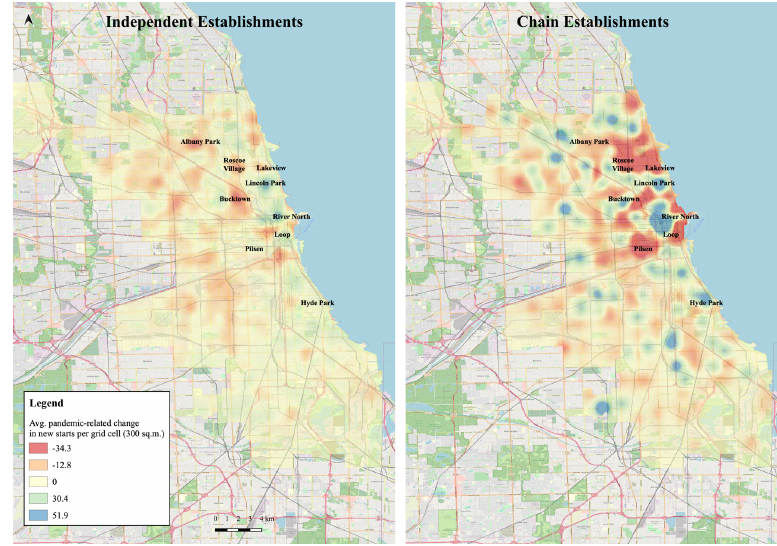
Figure 7: Difference in new start density between 2020 (March - Sept.) and average new start density from 2016 - 2019 (March - Sept.) for independent and chain establishments